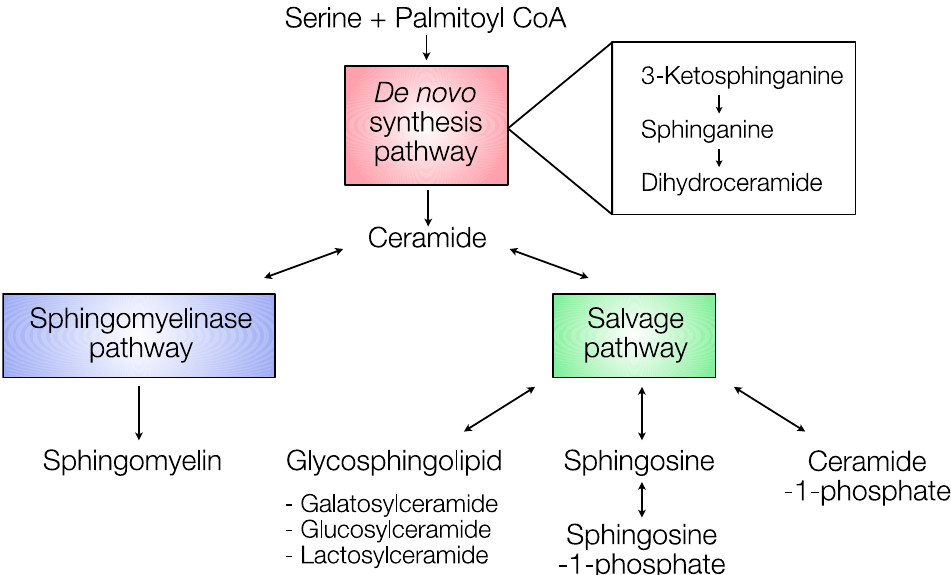
Figure 1. Sphingolipid metabolic pathways according to Merrill [8], and Maceyka and Spiegel [9]. The de novo synthesis pathway (red) begins with the condensation of serine and palmitoyl coenzyme A (CoA) to form ceramide through a series of reactions including the conversion of 3-ketosphinganine, sphinganine, and dihydroceramide. Ceramide can be modified into sphingomyelin via the sphingomyelinase pathway (blue) or into glycosphingolipid, sphingosine, and ceramide-1-phosphate via the salvage pathway (green). Double arrows indicate reversible reactions.